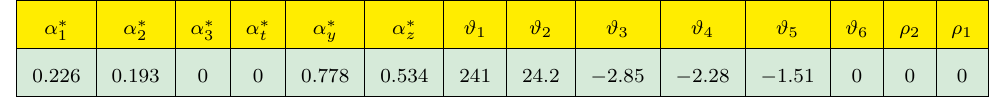
Table 11 . Values of the couplings at the (cid:12)xed point of interest, eigenvalues and (cid:26) ratios for the model combining 3 (cid:12)elds in the representation (1 ; 2 ; 3 = 2) and 8 (cid:12)elds in the representation (1 ; 5 ; 0) ( 210 approximation